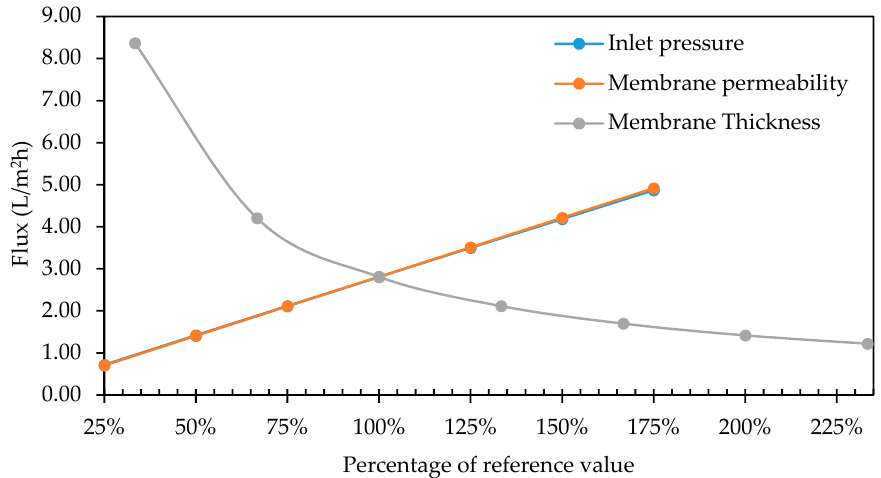
Figure 13. Relationship between intrinsic membrane permeability, total pure water flux leaving the module and membrane thickness.